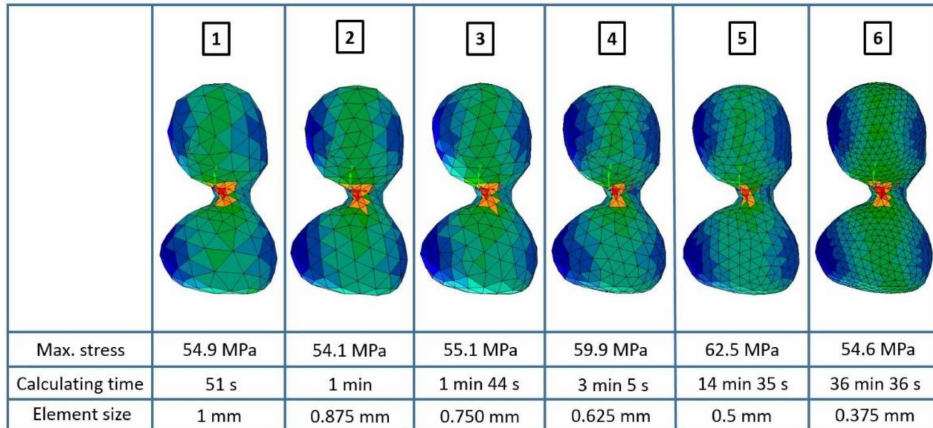
Figure 11. FE analysis of the stress level according to pore shapes under vertically or horizontally load (perpendicular to the plane of the largest projected area). The load direction is highlighted in yellow.